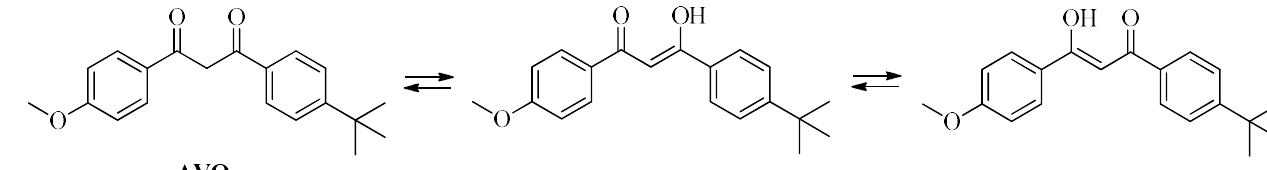
Figure 3. Keto-enol tautomers of AVO